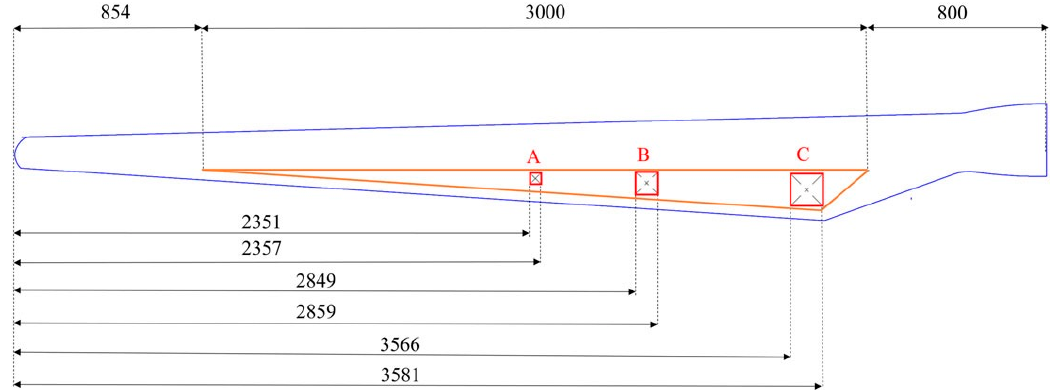
Figure 4. Defect locations in the faulty WTB. A, B and C areas are the disbonds between the honeycomb and the skin.